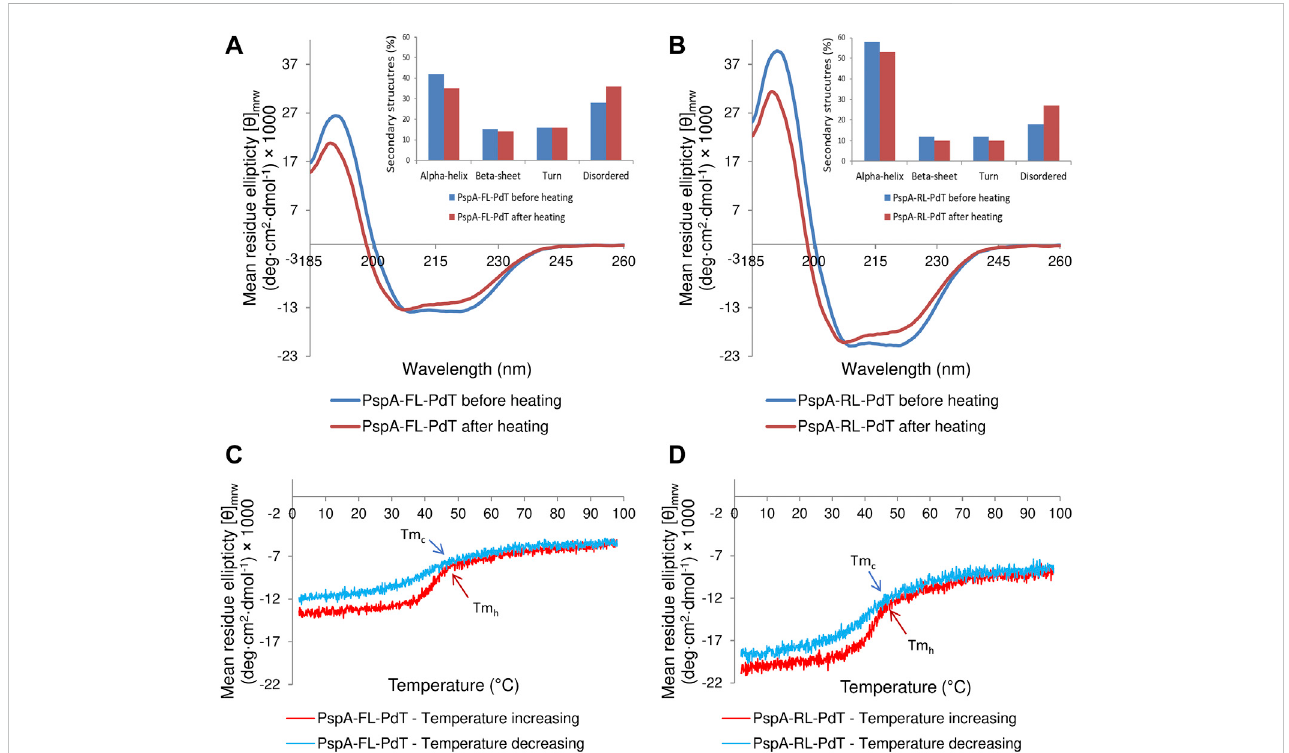
Circular dichroism spectra obtained for rPspA-FL-PdT and rPspA-RL-PdT. (A, B) CD spectra from 185 to 260 nm for rPspA-FL-PdT and rPspA-RL-PdT, respectively.Theinsetgraphsshowthepercentageofeachsecondarystructurebeforeandafterheating,estimatedbythedeconvolutionofspectrausingthe